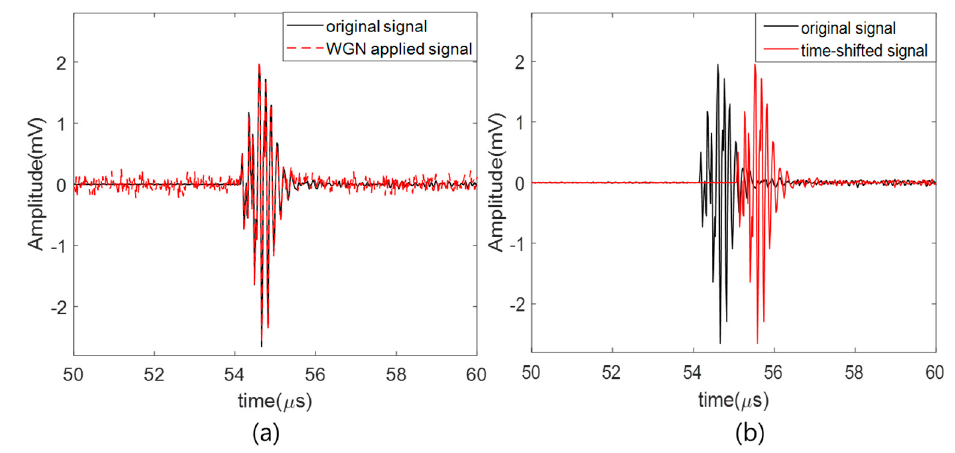
Figure 6. Augmented ultrasonic signal: ( a ) applied WGN with SNR, ( b ) time shifting. Table 2. Augmented database.